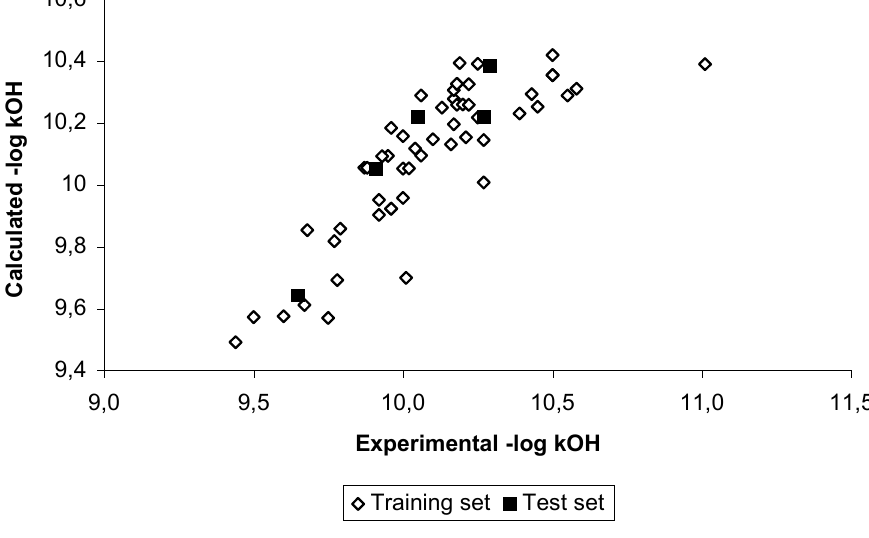
) values using variable connectivity index (Model OH